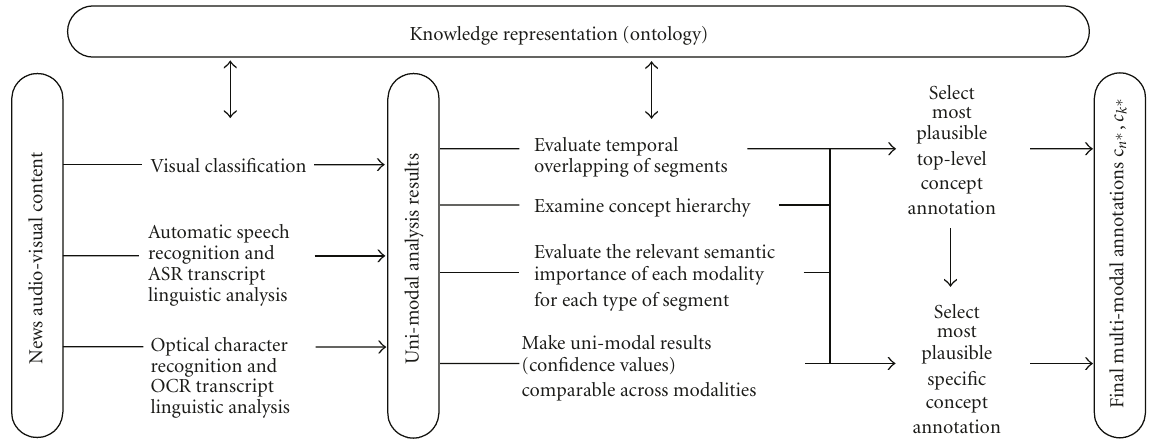
Figure 1: Overview of the proposed approach for multimodal analysis of news audio-visual content.